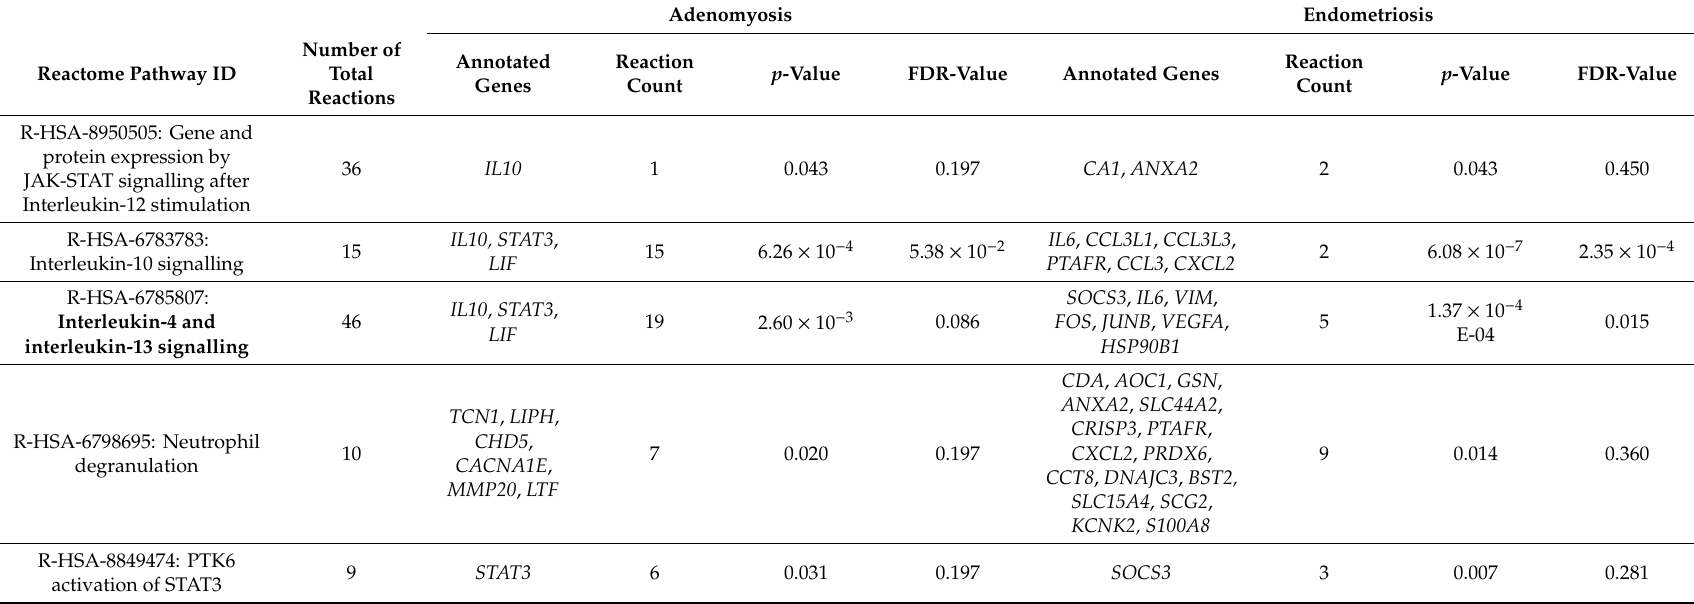
Table 3. Retrieved overlapping enriched pathways after gene set enrichment analysis (GSEA) between adenomyosis and endometriosis gene lists. Interleukin-4 and interleukin-13 signalling (marked in bold) served as a source for prioritisation of annotated genes for validation